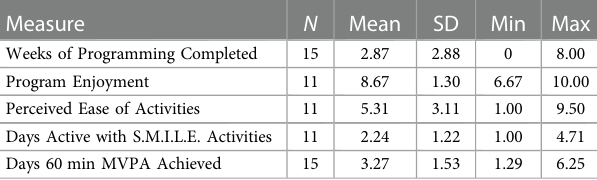
TABLE 4 Descriptive data from weekly survey